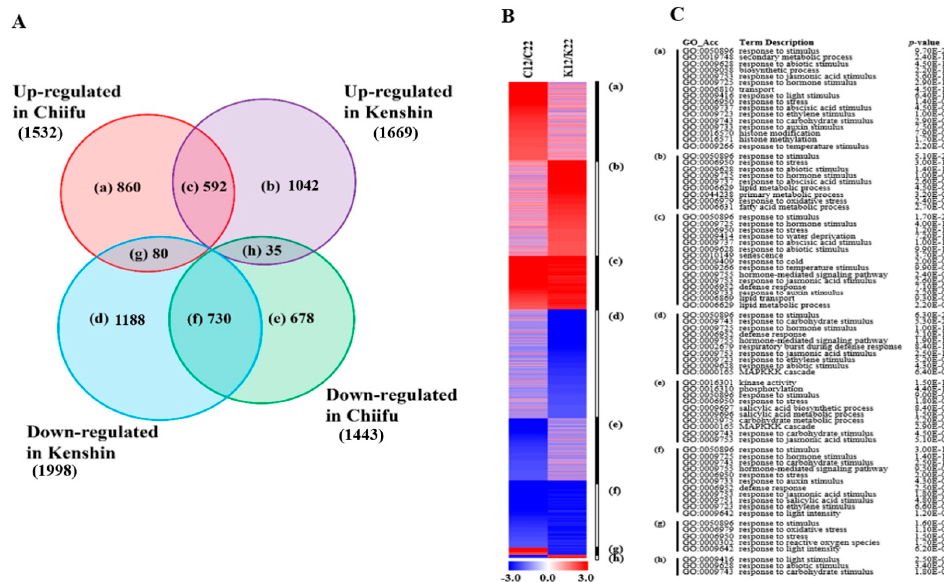
Figure 4. Analysis of LT-responsive genes from two contrasting inbred lines, Chiifu and Kenshin. ( A ) Venn diagram of DEGs with over 2-fold differences in expression; a–h indicate the groups of genes in each category; ( B ) Heatmap of DEGs in each group based on fold change; ( C ) GO enrichment analysis of DEGs in each group, with p values obtained using the agriGO tool (http://bioinfo.cau.edu.cn/agriGO/index.php). C and K of Figure 4B indicate Chiifu and Kenshin, respectively.